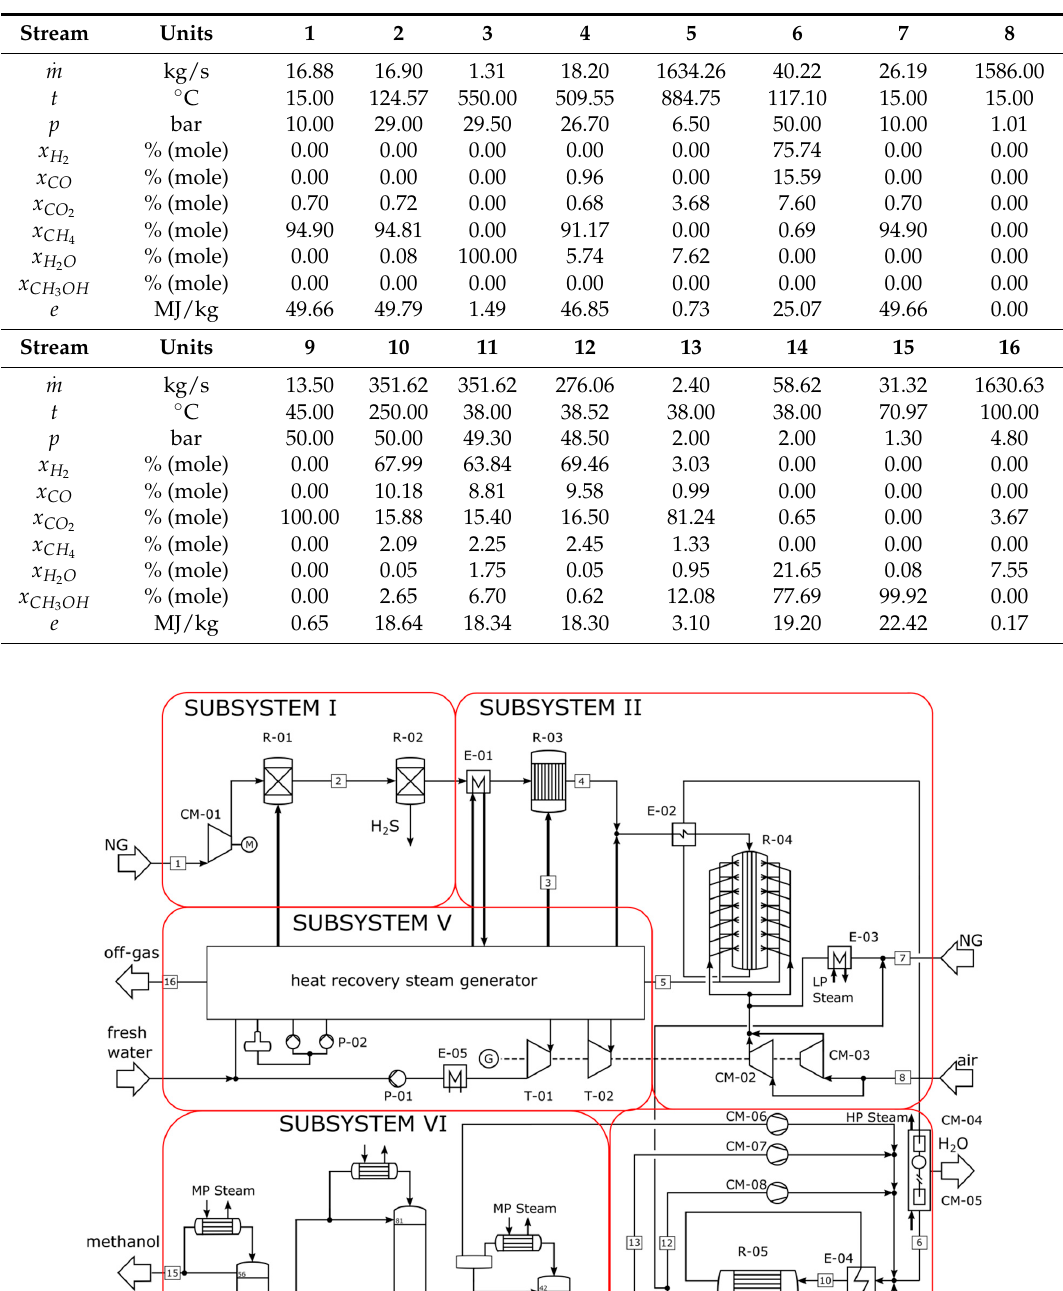
Table 3. Stream data of the methanol plant with steam–methane reforming (Case I).